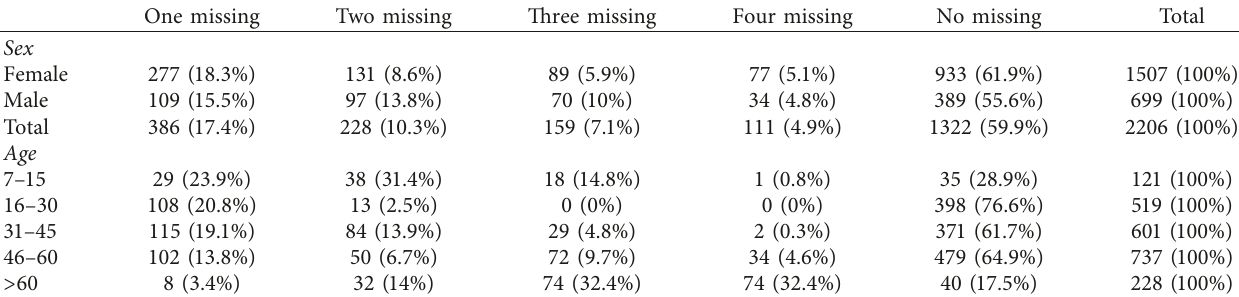
Table 1: Frequency of first molar missing according to sex and age group.